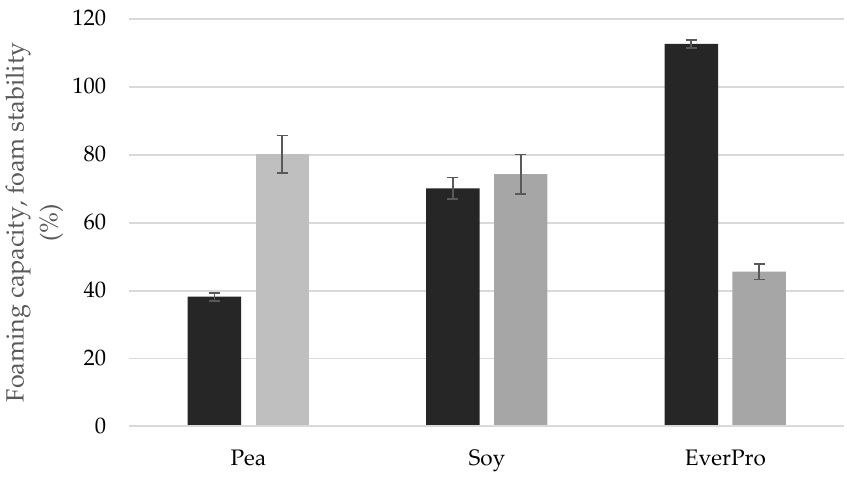
Figure 4. The foaming capacity (black bars) and foam stability (grey bars) of pea, soy and EverPro.